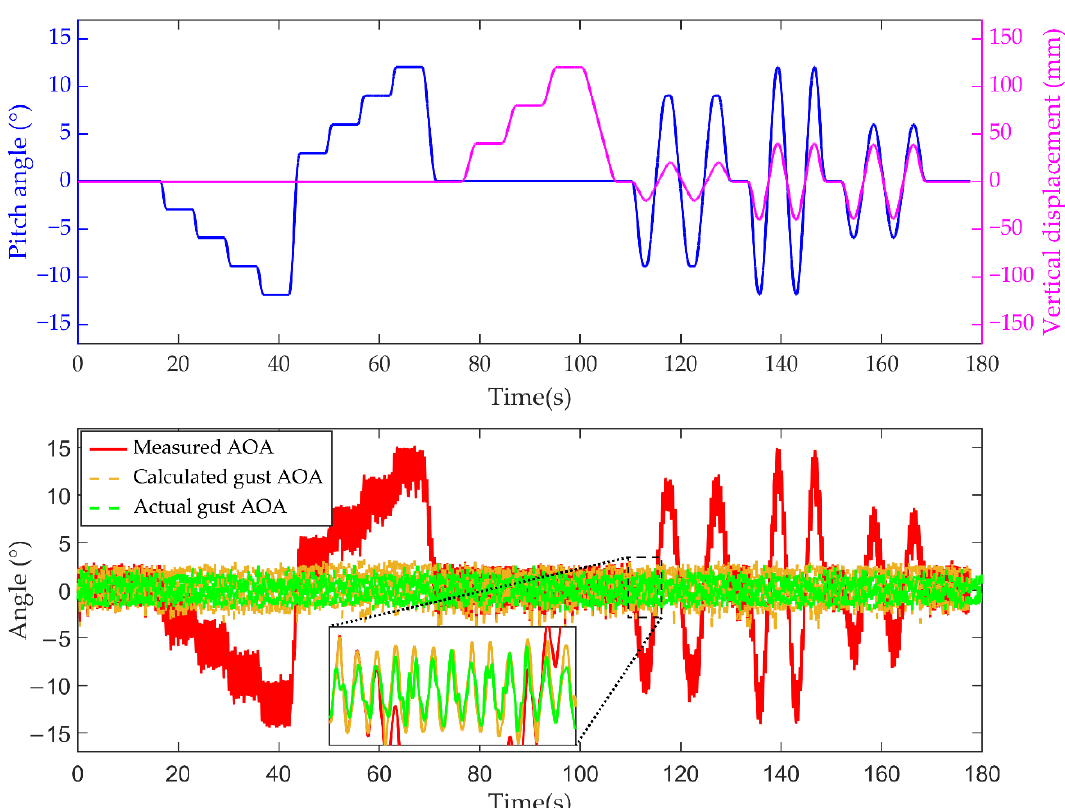
Figure 10. Plunging – pitching motion device movement process and gust calculation result. Figure 10. Plunging–pitching motion device movement process and gust calculation result.